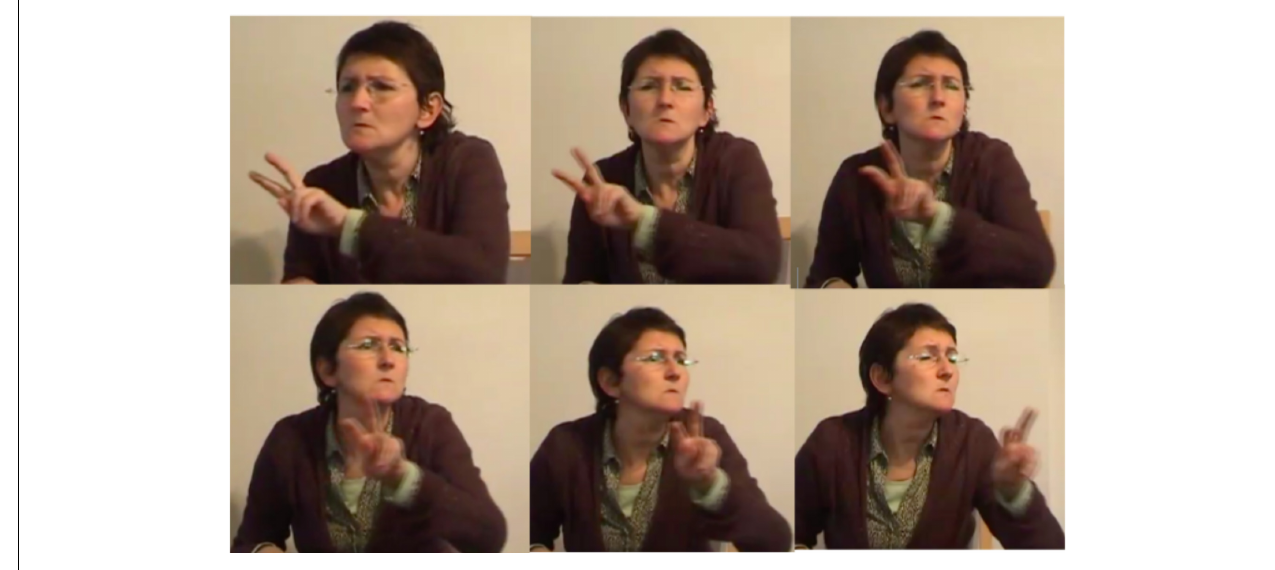
FIGURE 13 | Modified indicating verb TO-LOOK-AT, as produced in example 4.